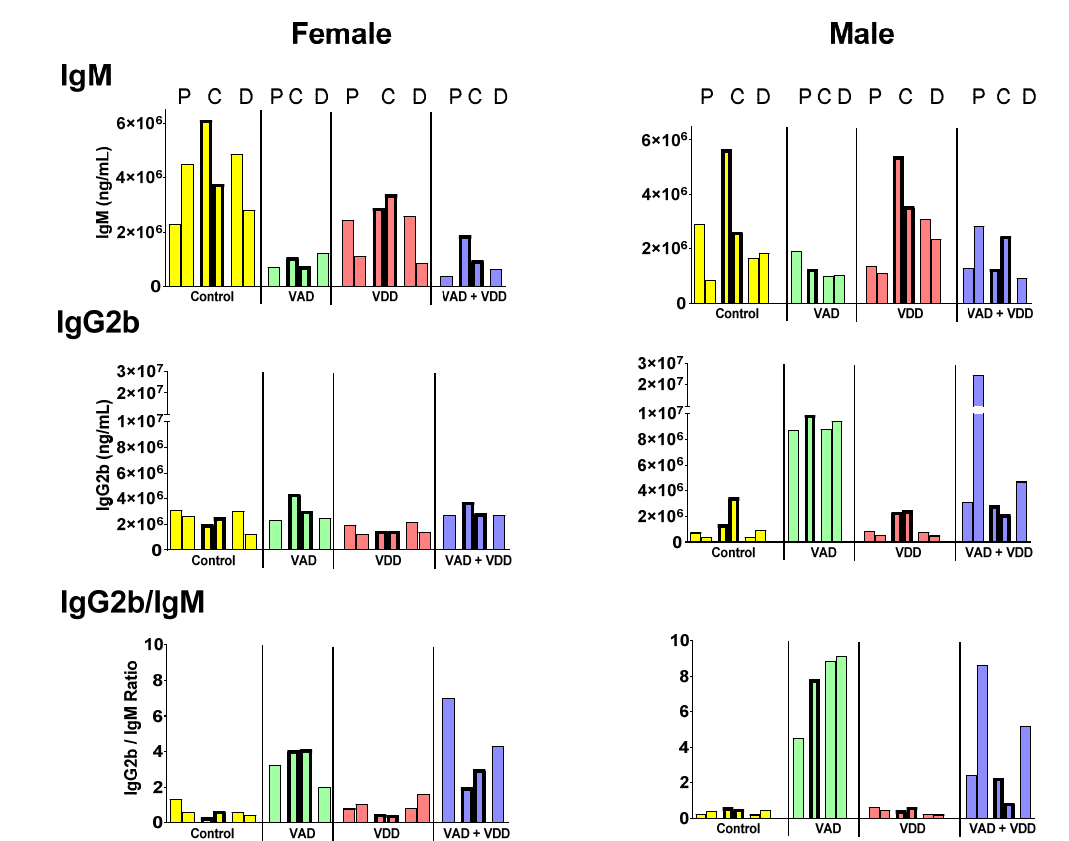
Figure 1. Serum immunoglobulin isotypes in animal groups. Isotypes and isotype ratios are shown for mice that were injected with PBS, complete and incomplete Freund’s adjuvant (emulsified with PBS alone [termed CFA] or DNA + Fus-1 peptide [termed CFA / DNA / PEP]). Mice received one prime and one booster injection and were bled 6 days after the booster. Data from mice injected with PBS only were described previously [16]. Bars represent the total immunoglobulin levels (ng / mL) for individual mice (Yellow = control mice; green = vitamin A deficient [VAD] mice; pink = vitamin D deficient [VDD] mice; blue = double deficient [VAD + VDD] mice). For each group of females or males, the bars represent mice injected with PBS (P, thin borders) CFA (C, thick borders), or CFA / DNA / PEP (D, thin borders). When the mice received similar injections, the bars were placed side-by-side with no intervening space.